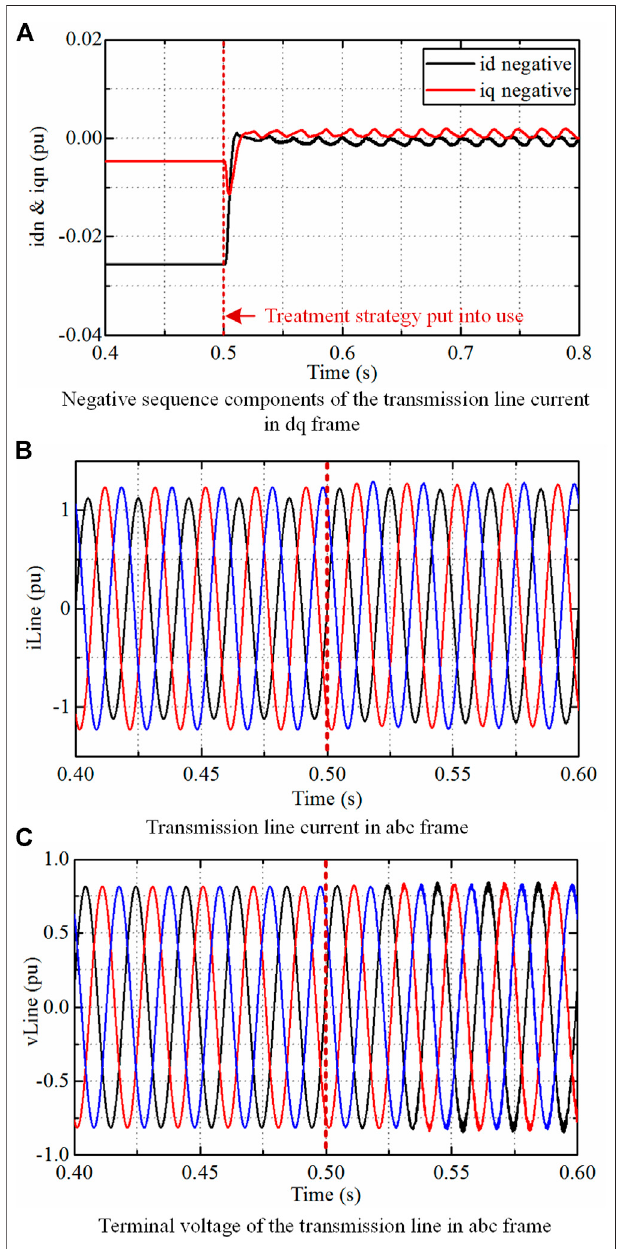
FIGURE 11 | Treatment strategy performance under asymmetrical transmission line